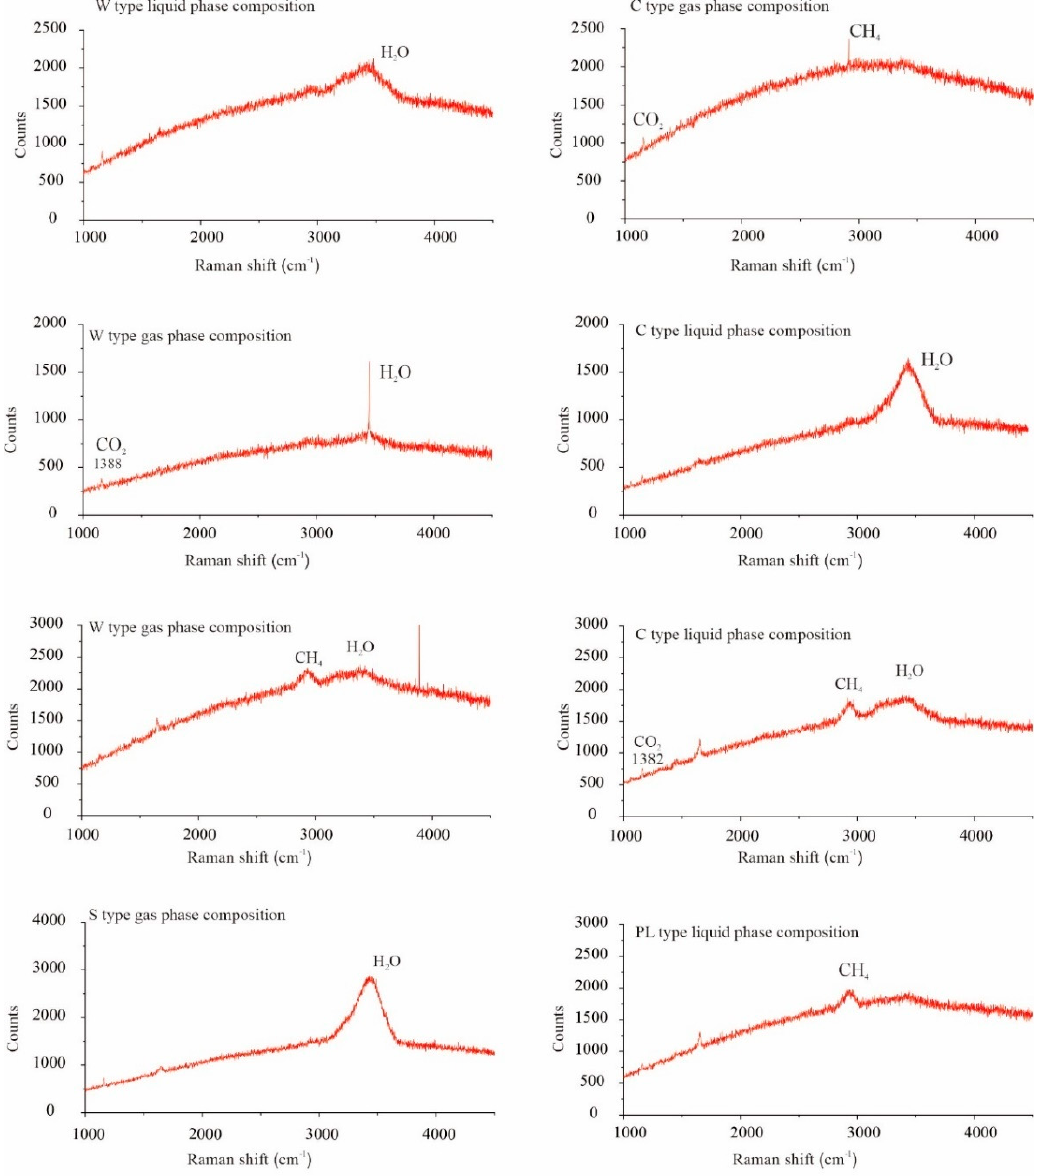
Figure 7. Laser Raman spectra of fluid inclusions from the Reshui Mo deposit.